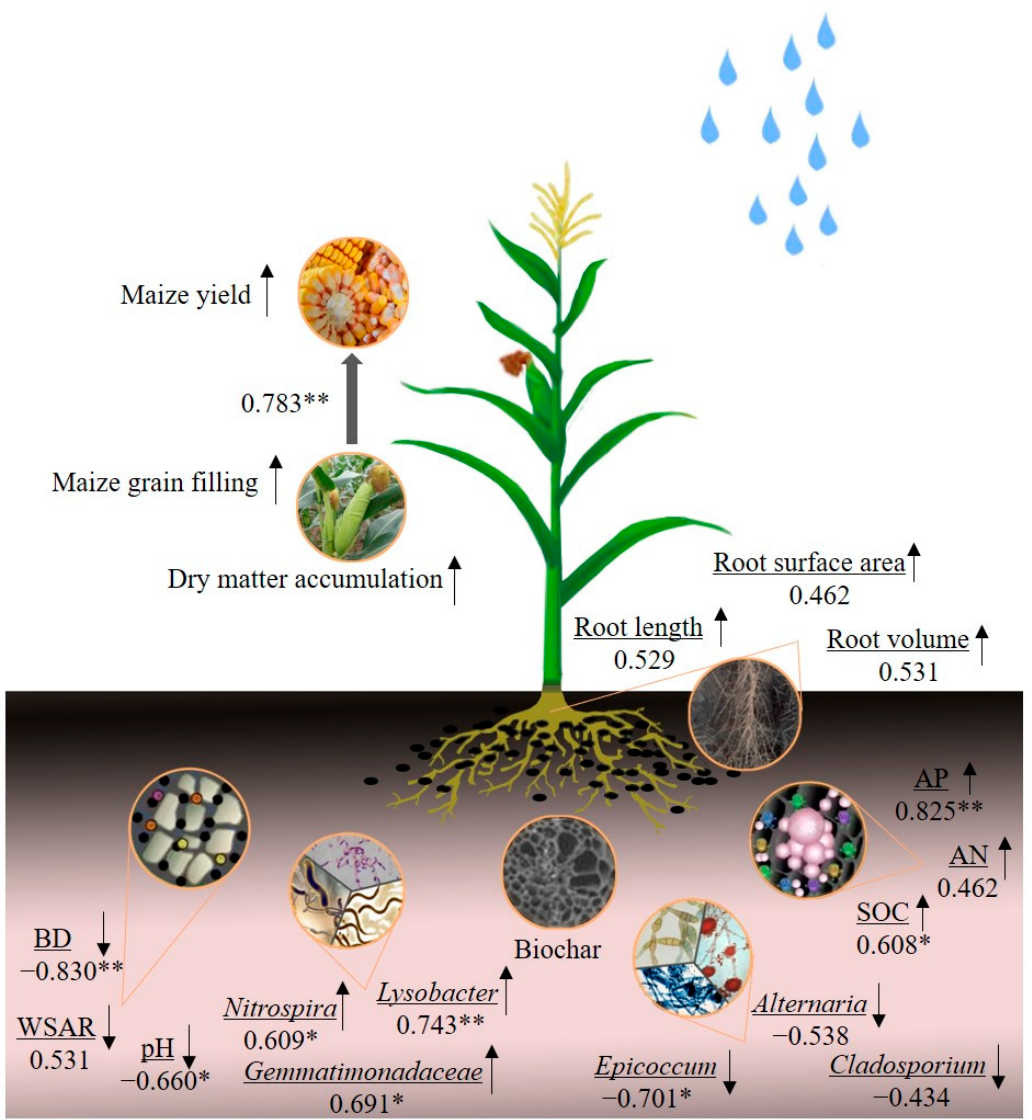
Figure 7. Response of soil microecological environment, maize plants, and yield to biochar addition. Note: BD: bulk density; WSAR: water-stable agglomerate stability rate; SOC: organic carbon; AN: alkaline nitrogen; AP: available phosphorus; ↑ indicates that biochar has a promotion effect. ↓ indi- cates that biochar has an inhibitory effect. The coefficients under the line the correlation coefficients between each index of soil microenvironment, root system, and dry matter accumulation at plant grain filling stage. * p < 0.05; ** p < 0.01. The correlation coefficient between dry matter accumulation at the plant grain filling stage and yield is 0.783.